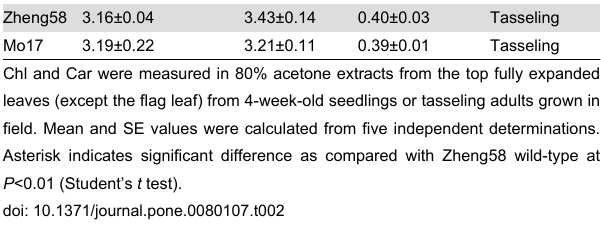
Cross Green leaf Yellow Leaf Theoretical Ratio χ 2